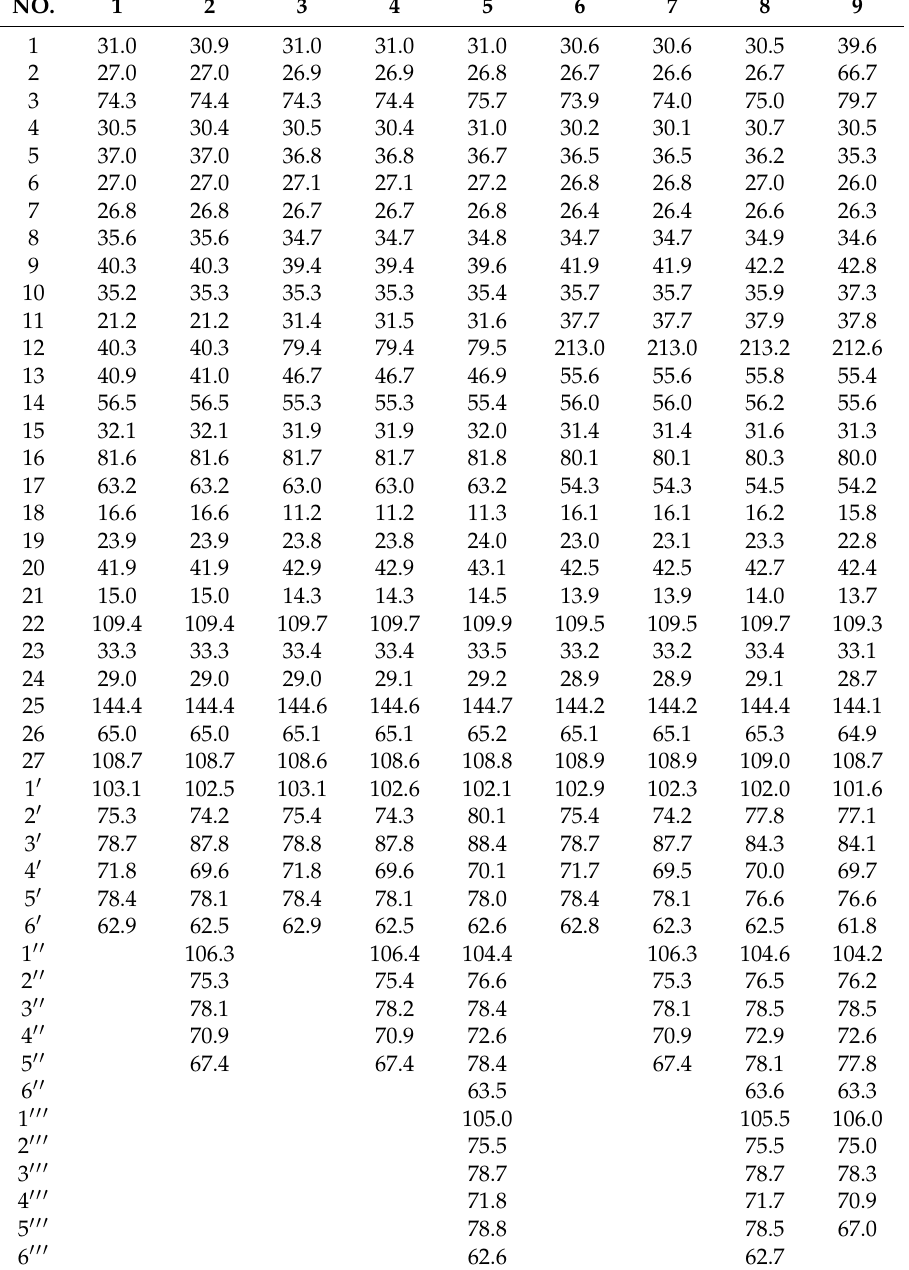
Table 1. 13 C NMR data for 1 – 9 in C 5 D 5